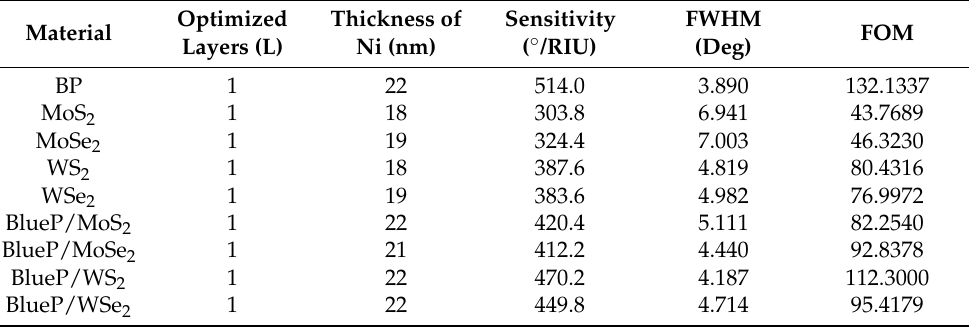
Table 2. The highest angular sensitivity for the SPR sensors based on Al(40 nm)–Ni–2D material at the refractive index of